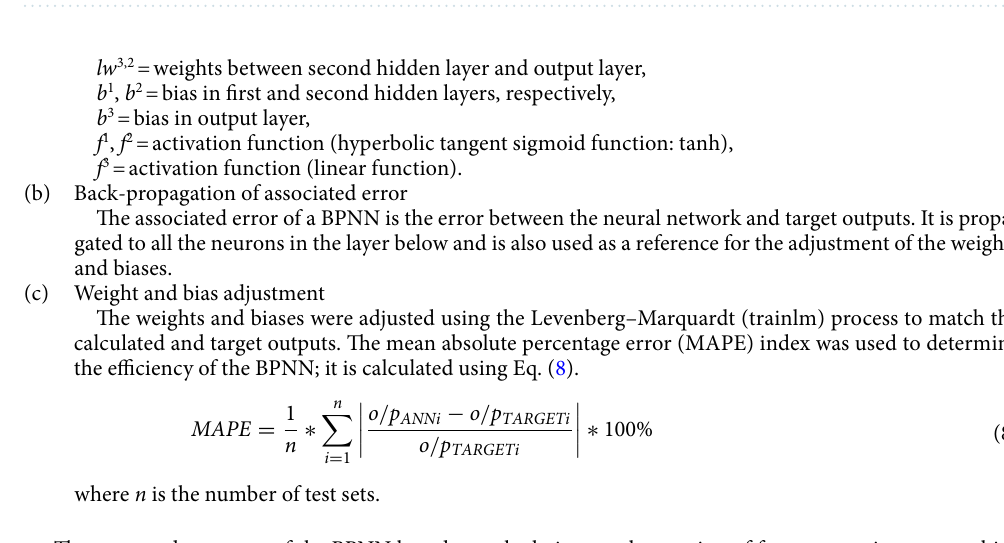
Table 2. Combinations of activation functions for training neural